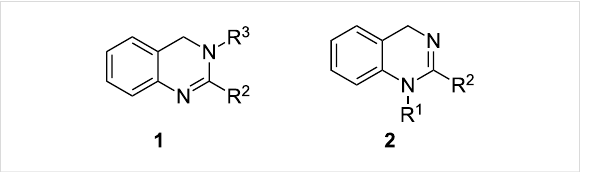
Figure 1: 3,4-Dihydroquinazolines 1 and 1,4-dihydroquinazolines 2